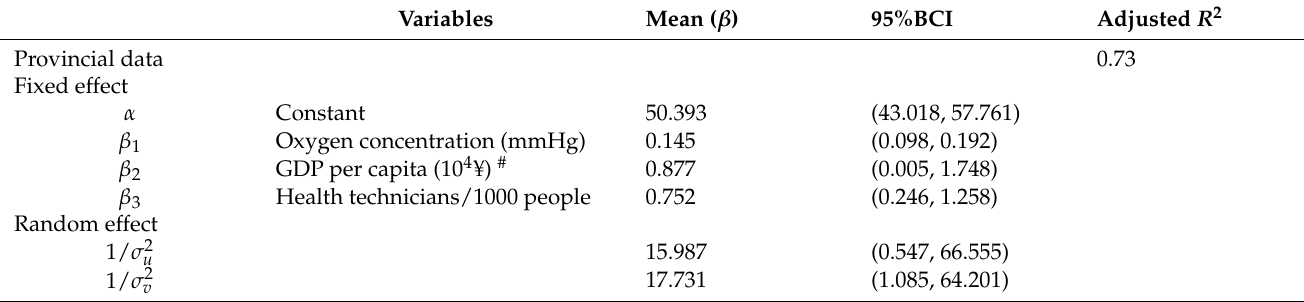
Table 2. Quantitative analysis of the association between life expectancy and oxygen concentration using Bayesian regression